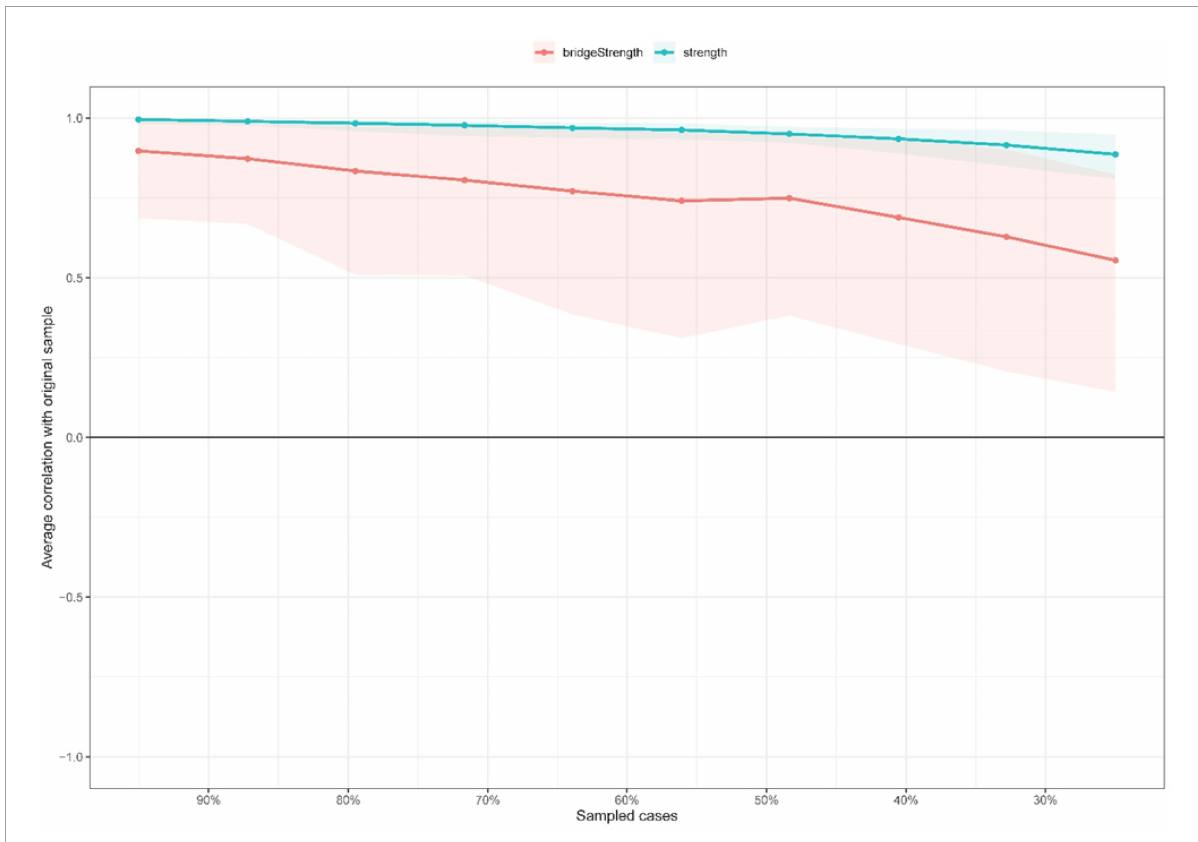
FIGURE4 Stability of network structure by case dropping subset bootstrap. The x-axis represents the percentage of cases of the original sample used at each step. The y-axis represents the average of correlations between the centrality indices in the original network and the centrality indices from the re-estimated networks after excluding increasing percentages of cases. The lines indicate the correlations between strength and bridge